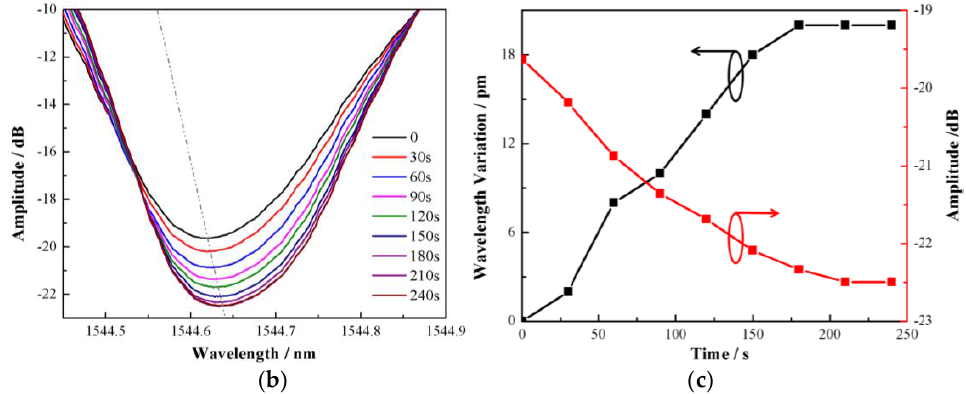
Figure 4. ( a ) The spectrum of the TFBG near the SPR resonance and the cladding modes selected for demodulation. ( b ) The spectral responses of the cladding mode next to the SPR resonances, and the reaction between boronic acid derivative and concanavalin A (Con A) was about 240 s. ( c ) The corresponding data analysis to monitor Con A via the developed TFBG-based sensor. The wavelength sensitivity was 20 pm/(mg/mL), while increasing the time of interaction results in a decrease of amplitude from −19.628 to −22.495 dB.